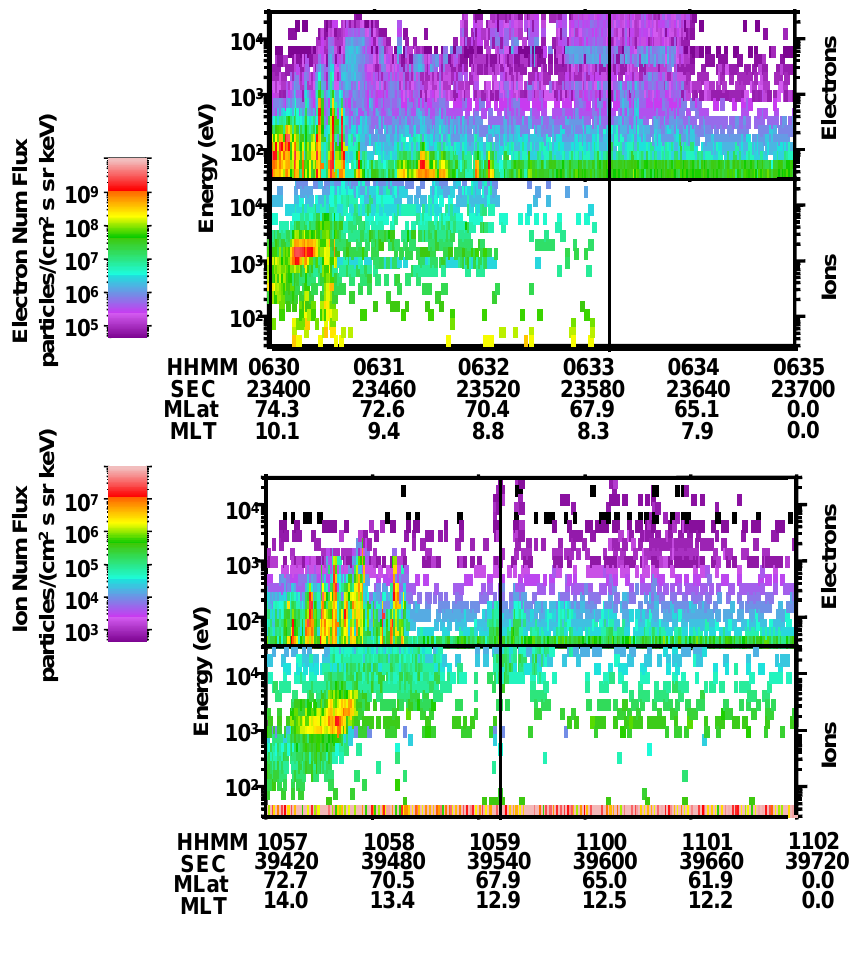
Fig. 4. Two passes from DMSP satellites are shown. The black vertical lines illustrate the times of crossing the magnetic latitude of EISCAT. The top panel is from the F13 spacecraft around 06:30UT. The bottom panel is a pass by the F10 satellite close to